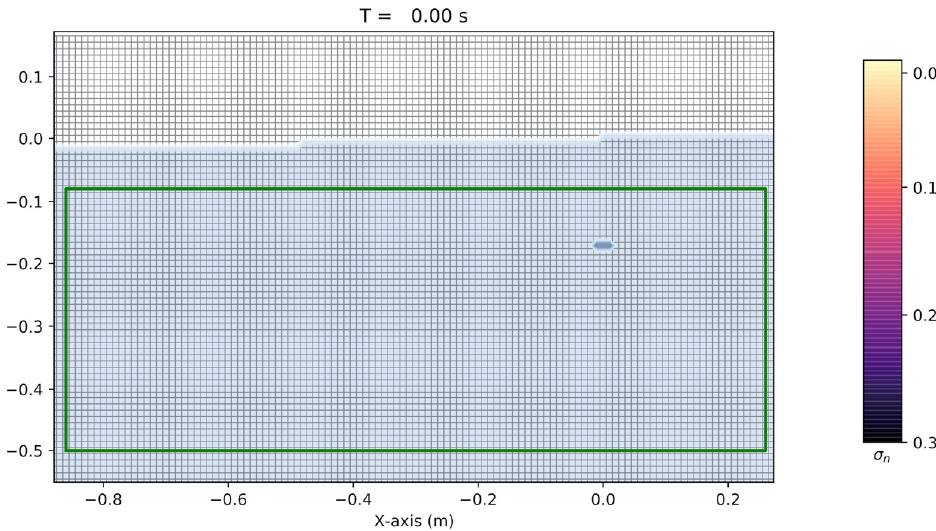
Figure 4. The grid geometry used in the numerical simulation of an immiscible DNAPL inside a saturated sandbox and a grid dimension of 1.16 m × 0.10 × 0.80 m, at the initial time t = 0 s. The blue box is the immiscible DNAPL at the top of the parallelepiped in the z − x plane.